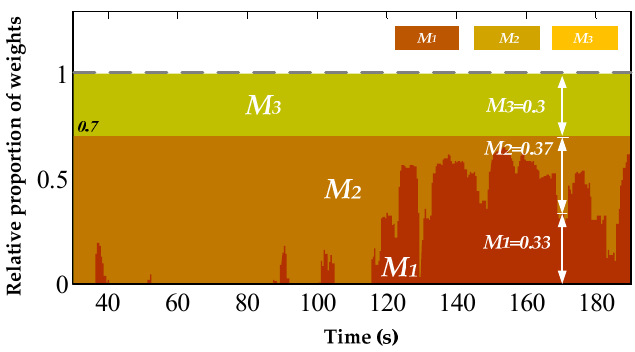
Figure 15. Weights variations of the proposed method with dynamic weights.